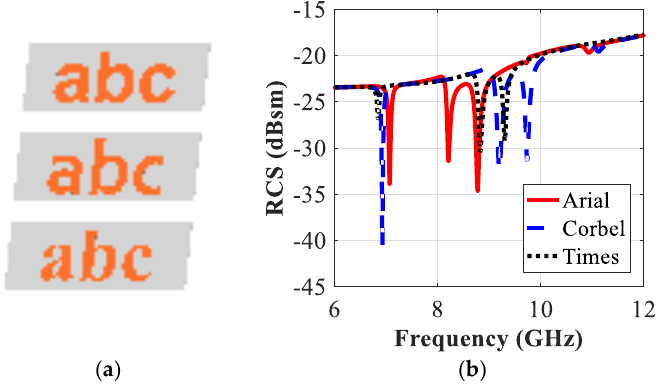
Di ff erent realized tags with and without click space; ( b ) Co-polar HH RCS responses.